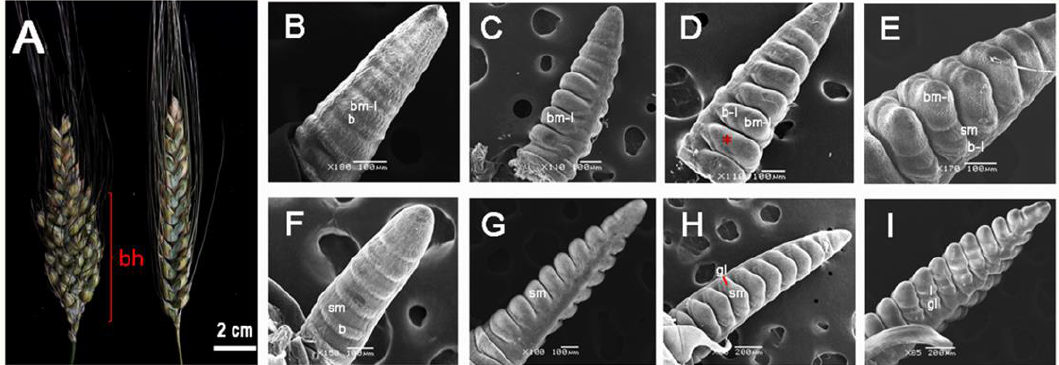
Figure 1. Morphology of the spikes of a normal head (nh) and the spikes of a branching head (bh). ( A ) Spike morphology of GAN-A631–left side (bh) and GAN-A1582–right side (nh). ( B ) The early double ridge (EDR) stage of bh. ( C ) The late double ridge (LDR) stage of bh. ( D ) The branch meristem (BM) development stage of bh and the red asterisk indicates the region of secondary spikelet meristem (SM) emergence. Compared with the glume primordia (GP) stage of nh, slight bulging can be observed at the location of the red asterisk in bh. ( E ) The SM initiation (SMI) stage of bh. ( F ) The EDR stage of nh. ( G ) The LDR stage of nh. ( H ) The GP stage of nh. ( I ) The lemma primordia (LP) stage of